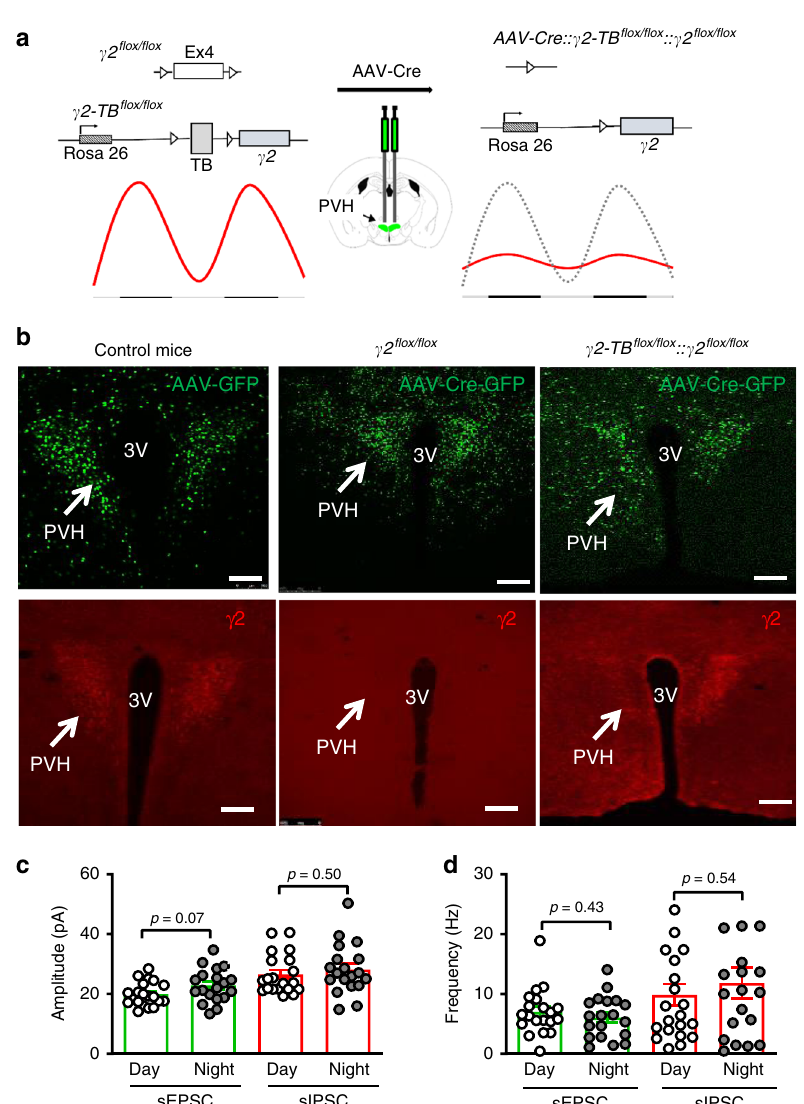
Fig. 5 Generation of mice with loss of diurnal rhythms of γ 2 subunit expression in adult PVH. a Diagram showing delivery of AAV-Cre-GFP to the PVH of γ 2 fl ox/ fl ox :: γ 2-TB fl ox/ fl ox to clamp γ 2 expression at a constant level in adult mice. Cre-mediated deletion of the endogenous γ 2 and expression of wild-type γ 2 cDNA driven by the ROSA26 promoter lead to replacement of rhythmic expression of γ 2 with a static expression level of γ 2 driven by the ROSA26 promoter. b Validation of viral delivery to the PVH with GFP for vector delivery and red for immunostaining of γ 2 expression. GFP expression (AAV-GFP or AAV-Cre-GFP) was veri fi ed in the PVH (top panels) and γ 2 expression was veri fi ed by immunostaining (bottom panels): no expression of γ 2 in Cre- mediated deletion (bottom middle, arrow) and re-expression by Cre-mediated γ 2 expression driven by the ROSA26 promoter (bottom right, arrow), noticing consistency in the expression between Cre-GFP (top right) and γ 2 (bottom right). c , d The amplitude ( c , n = 15 each) and frequency ( n = 12 for EPSCs and 14 for IPSCs) of sEPSCs and sIPSCs recorded during day and night periods from PVH neurons 3 – 4 weeks after AAV-Cre-GFP delivery. All data are represented as mean ± SEM and analyzed by unpaired Student ’ s t -tests. TB transcription blocker. Scale bars: 200 µ m, 3V third ventricle. Source data are provided as a Source Data fi